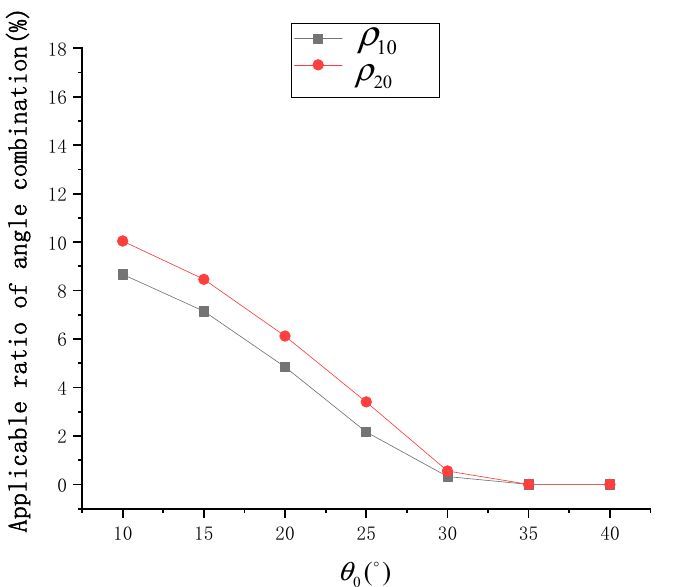
Figure 14. Statistical results of ρ 10 and ρ 20 at di ff erent sun zenith angles ( θ 0